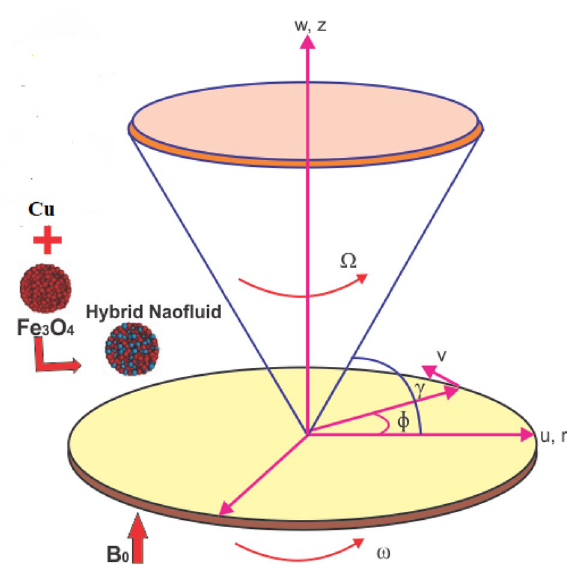
Figure 1. Geometry of the